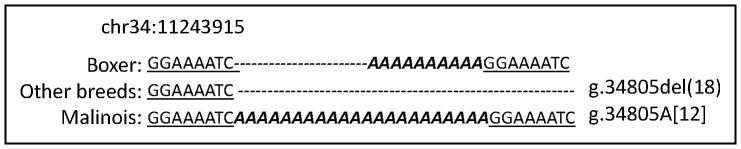
Three alleles at polyA site.Allele differences beginning at chr34∶11243915 (Broad CanFam3.1) for Boxer reference sequence (“polyA(10)”), the allele most common in other breeds in our dataset (g.34805del(18); “polyA(0)”), and the allele (g.34805A(12); “PolyA(22)”) found primarily in Malinois in our dataset.